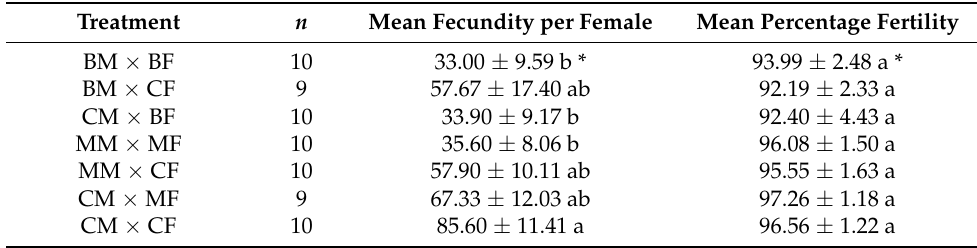
Table 4. Mean fecundity and fertility ( ± SE) of EPF-treated and untreated Tuta absoluta females after mating with either EPF-treated or untreated males.